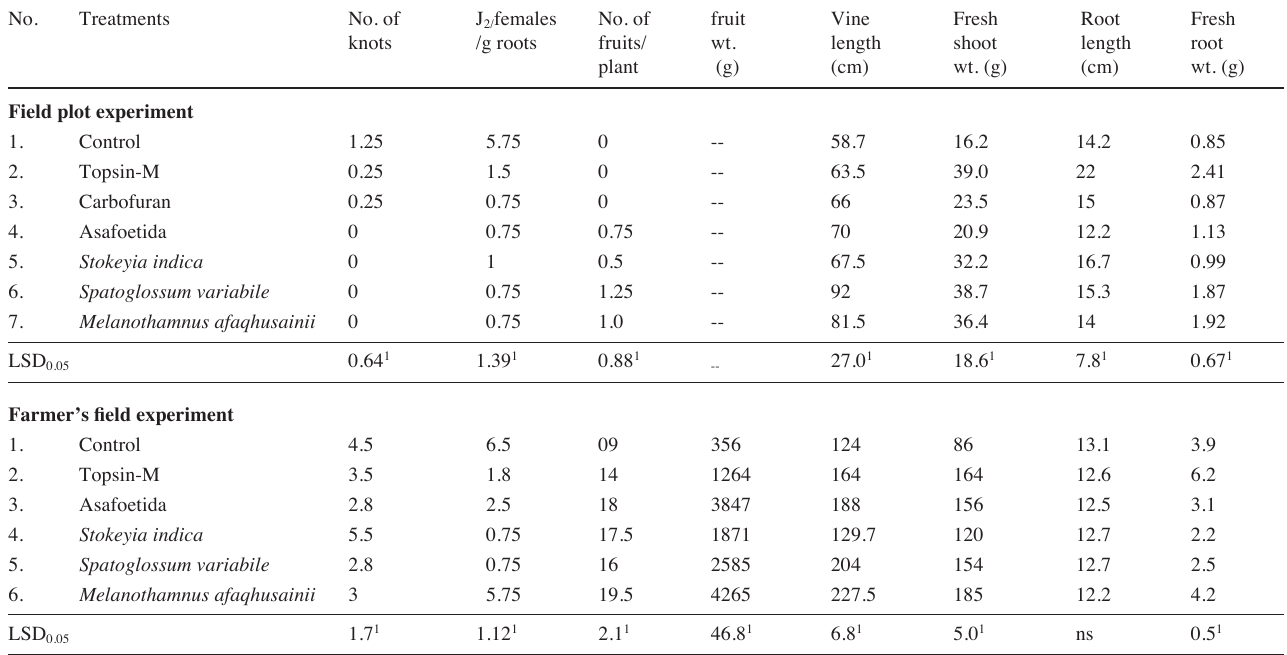
Tab. 4: Effect of asafoetida and seaweeds on the infection of root knot nematode and growth of watermelon in field plot (after 45 days of nematode inocu- lation) and at farmer’s field (after 80 days of sowing).